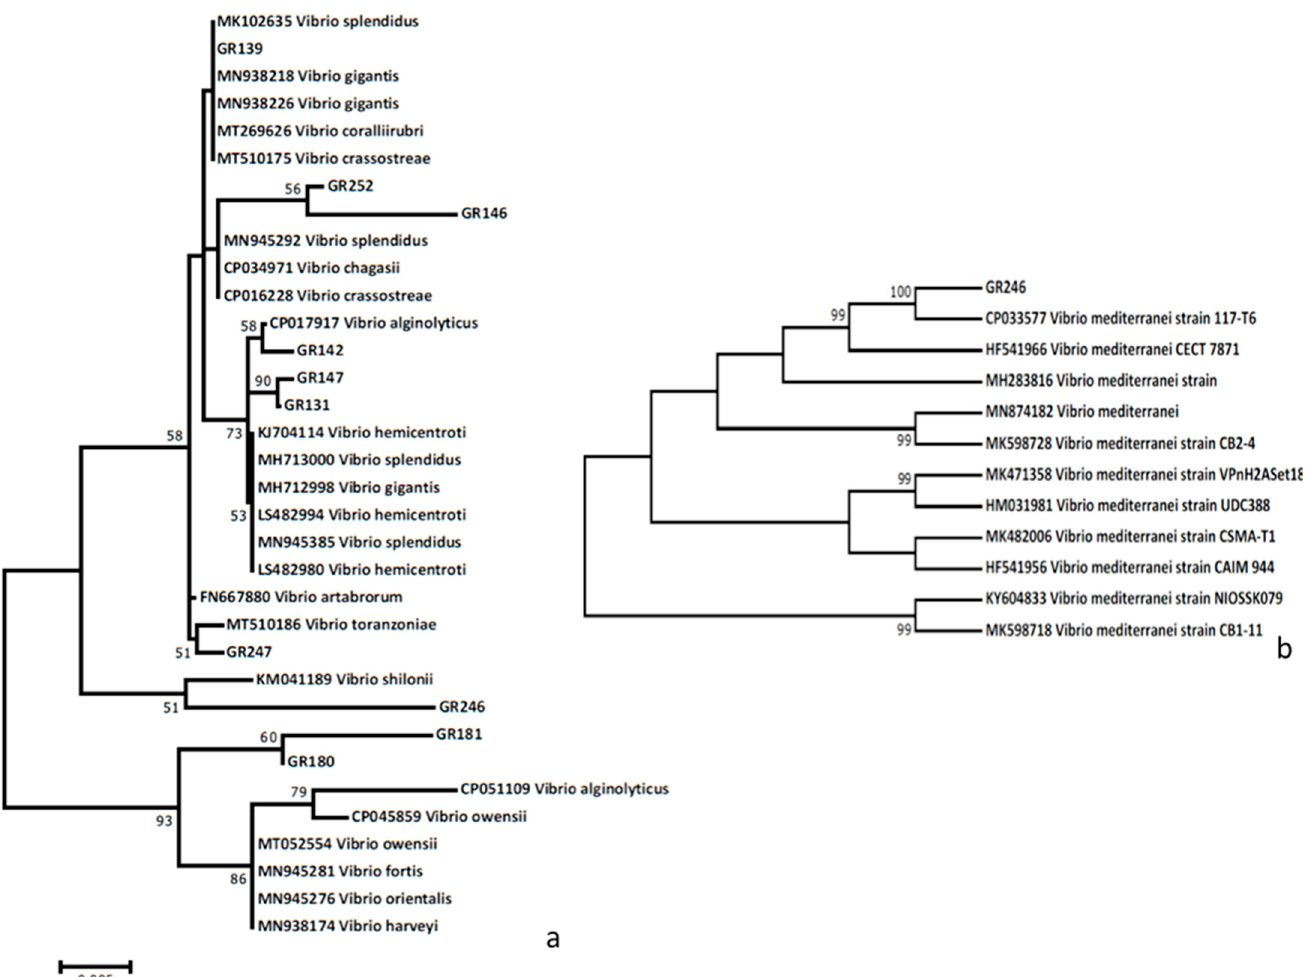
Figure 3. Phylogenetic relationship of the newly described Vibrio haplotypes in comparison with the most closely related ones, obtained from the GenBank database. ( a ) Maximum likelihood dendrogram including all newly described Vibrio haplotypes in comparison with the most closely related ones. ( b ) Maximum likelihood dendrogram including only V. mediterranei haplotypes. Haplotype names as in Table 1 .